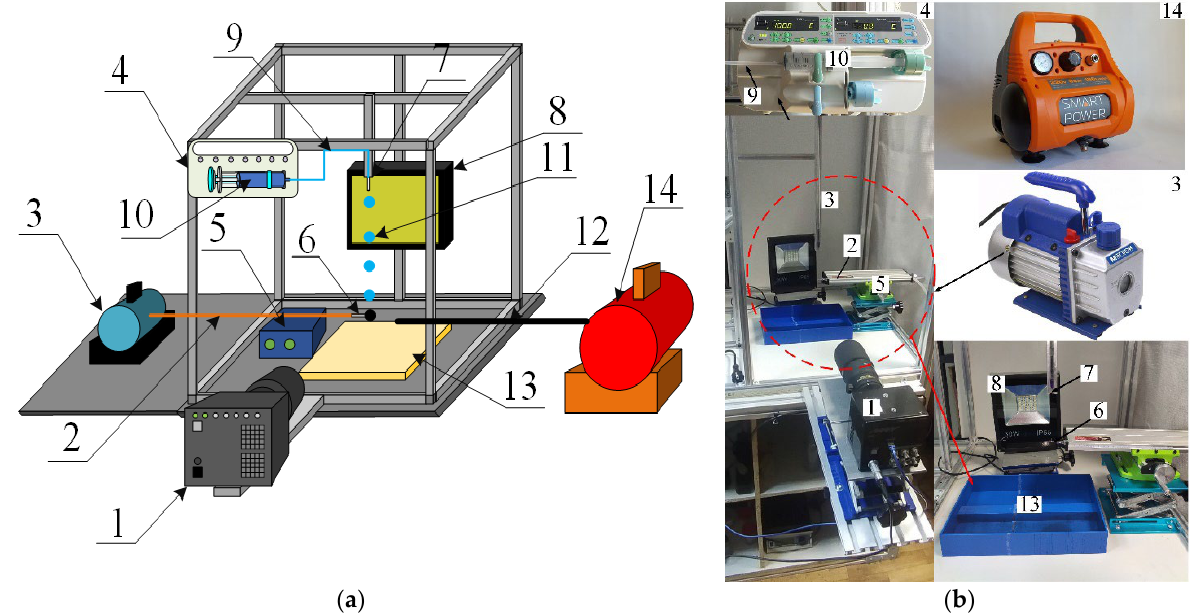
Figure 1. Experimental setup scheme ( a ) and photo ( b ): 1—high-speed video camera; 2—copper capillary of vacuum pump; 3—vacuum pump; 4—syringe pump; 5—positioning mechanism; 6—particle holder (a needle with a flat tip); 7—detachable nozzle; 8—spotlight; 9—liquid supply capillary; 10—syringe; 11—liquid droplet; 12—air supply capillary; 13—container to collect liquid; 14—air compressor.